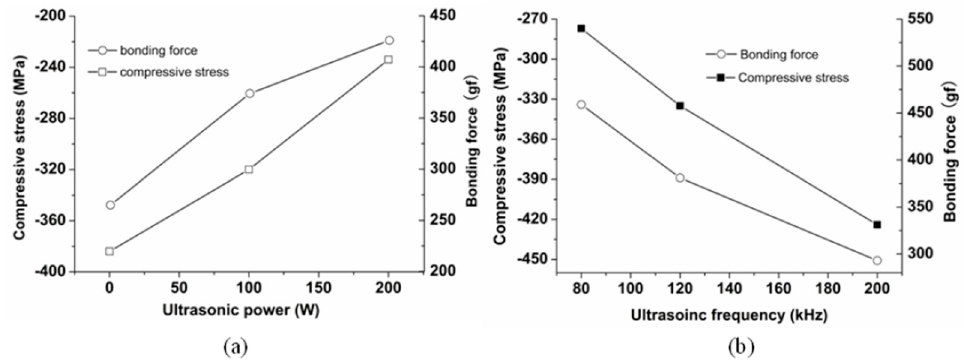
Figure 12. The changing trend of the bonding strength and the compressive stress along with the different ultrasonic parameters: ( a ) ultrasonic power; ( b ) ultrasonic frequency.